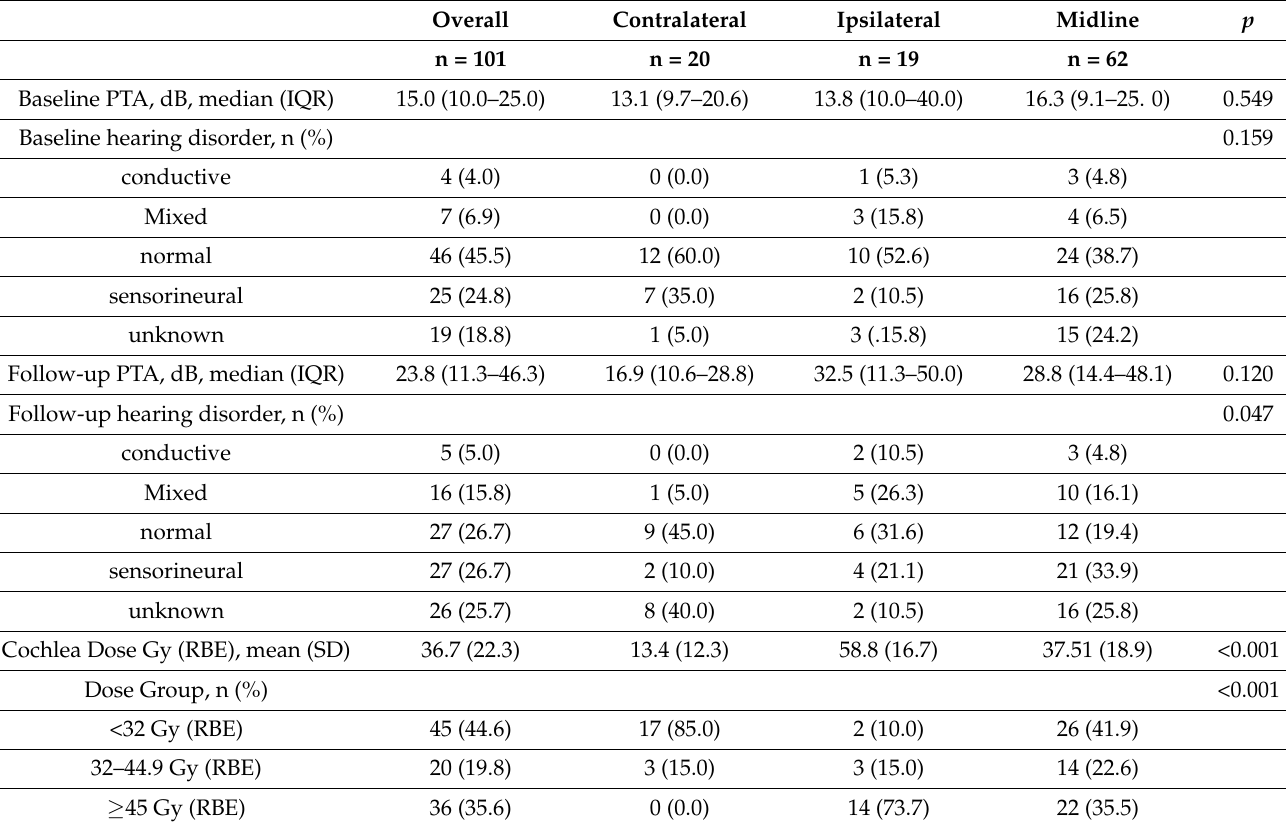
Table 3. The hearing outcome in the 101 ears of 51 patients.